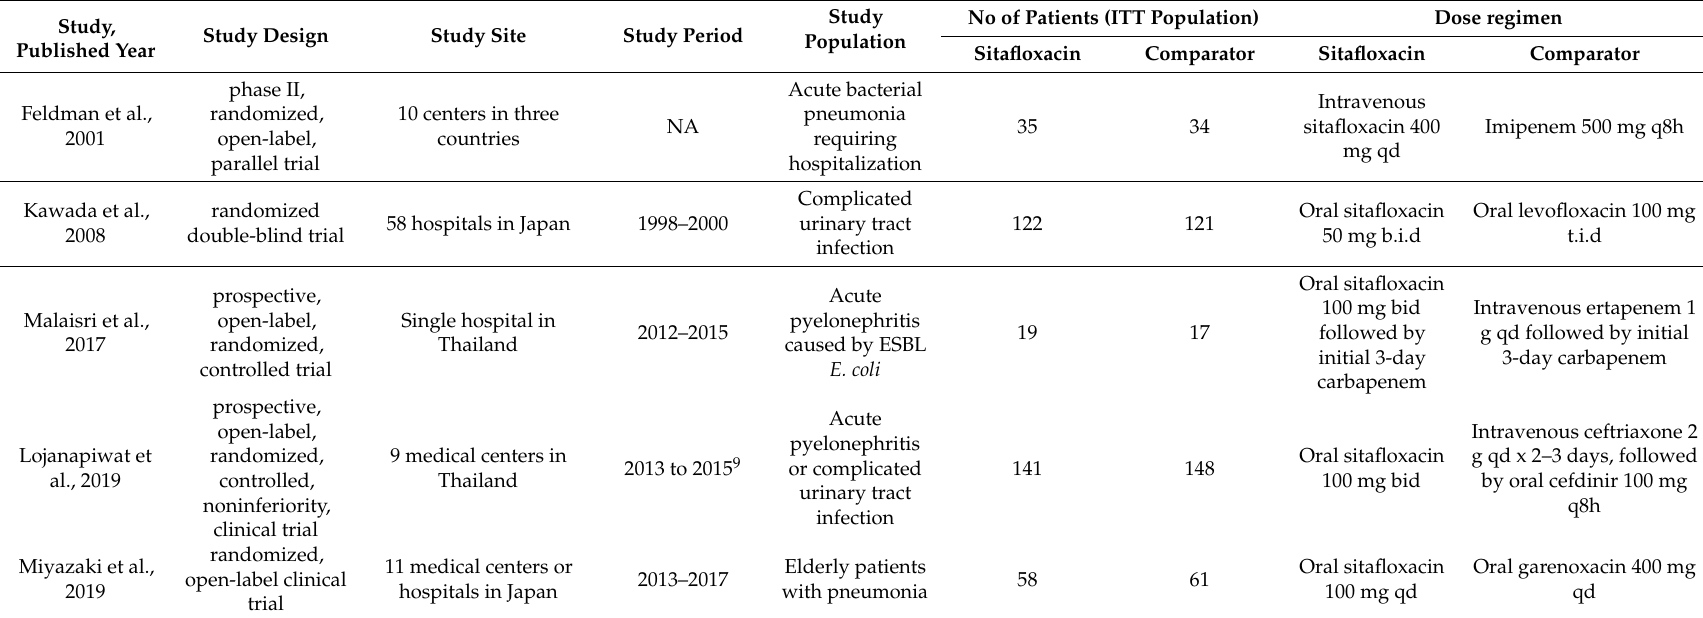
Table 1. Summary of the characteristics of enrolled studies in the